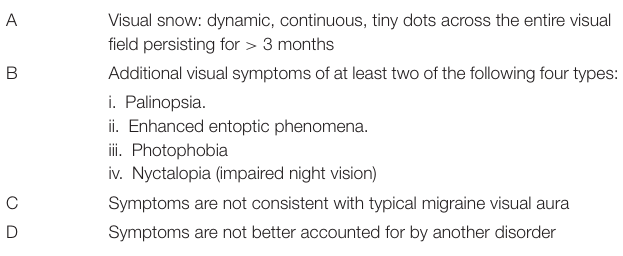
TABLE 1 | International classification of headache disorders (ICHD-3) criteria for a diagnosis of visual snow